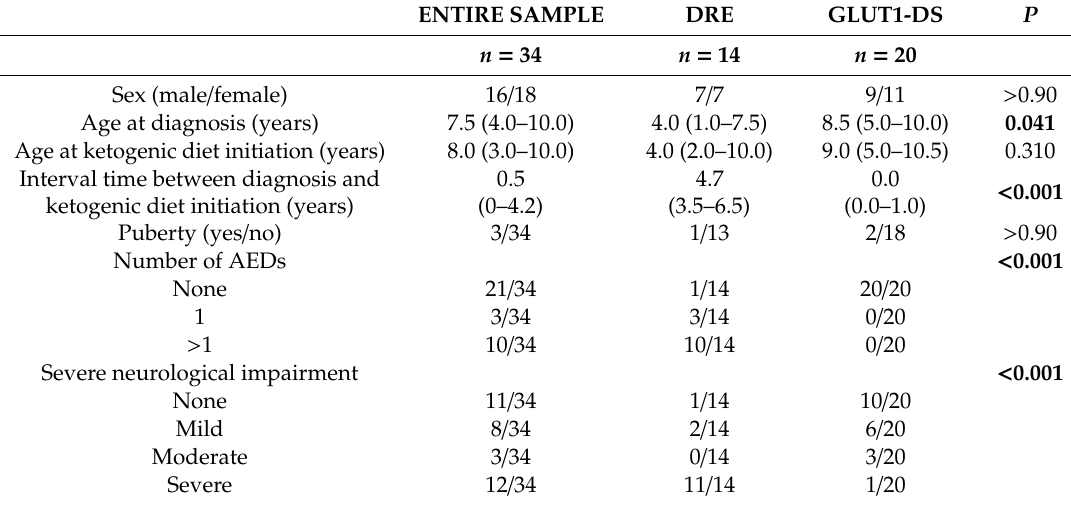
Table 1. Baseline characteristic of the entire sample and of drug-resistant epilepsy (DRE) and glucose transporter type 1 deficiency syndrome (GLUT1-DS)